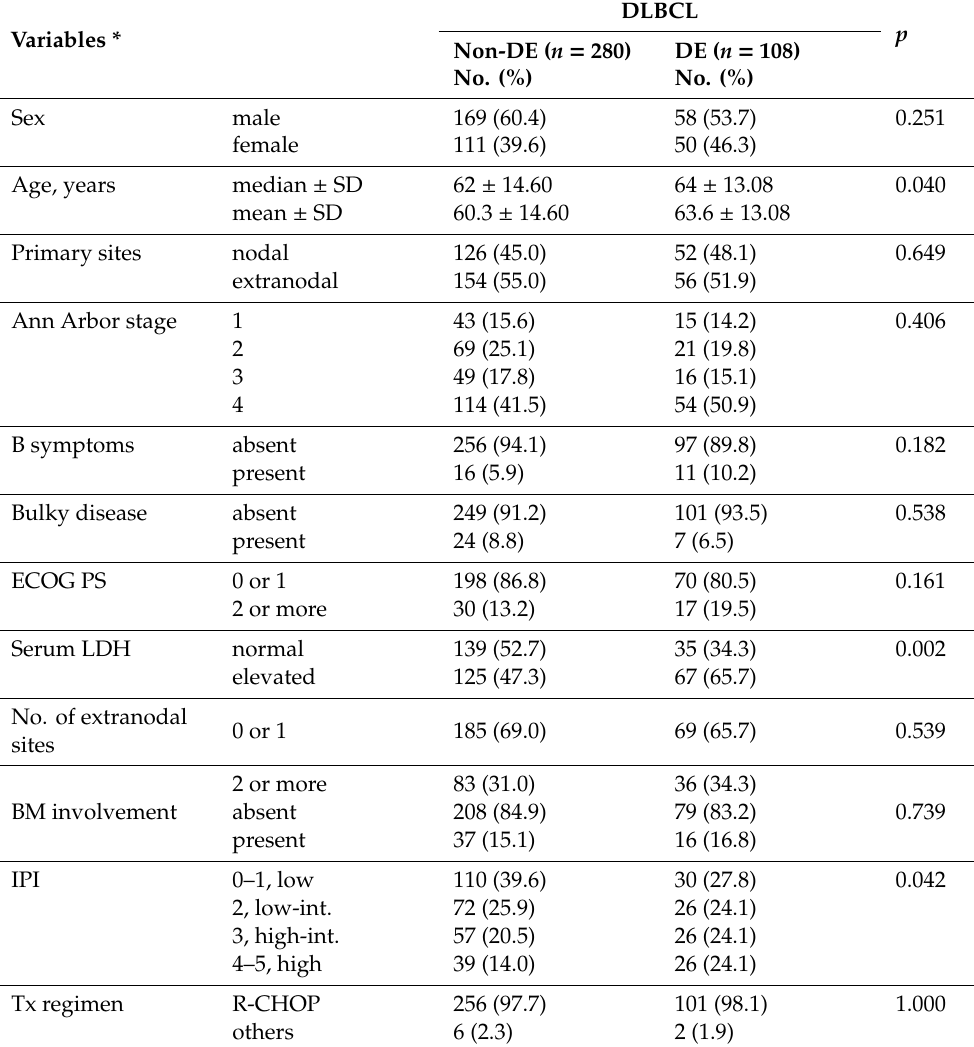
Table 2. The relationship between DE status and clinicopathological features of DLBCL